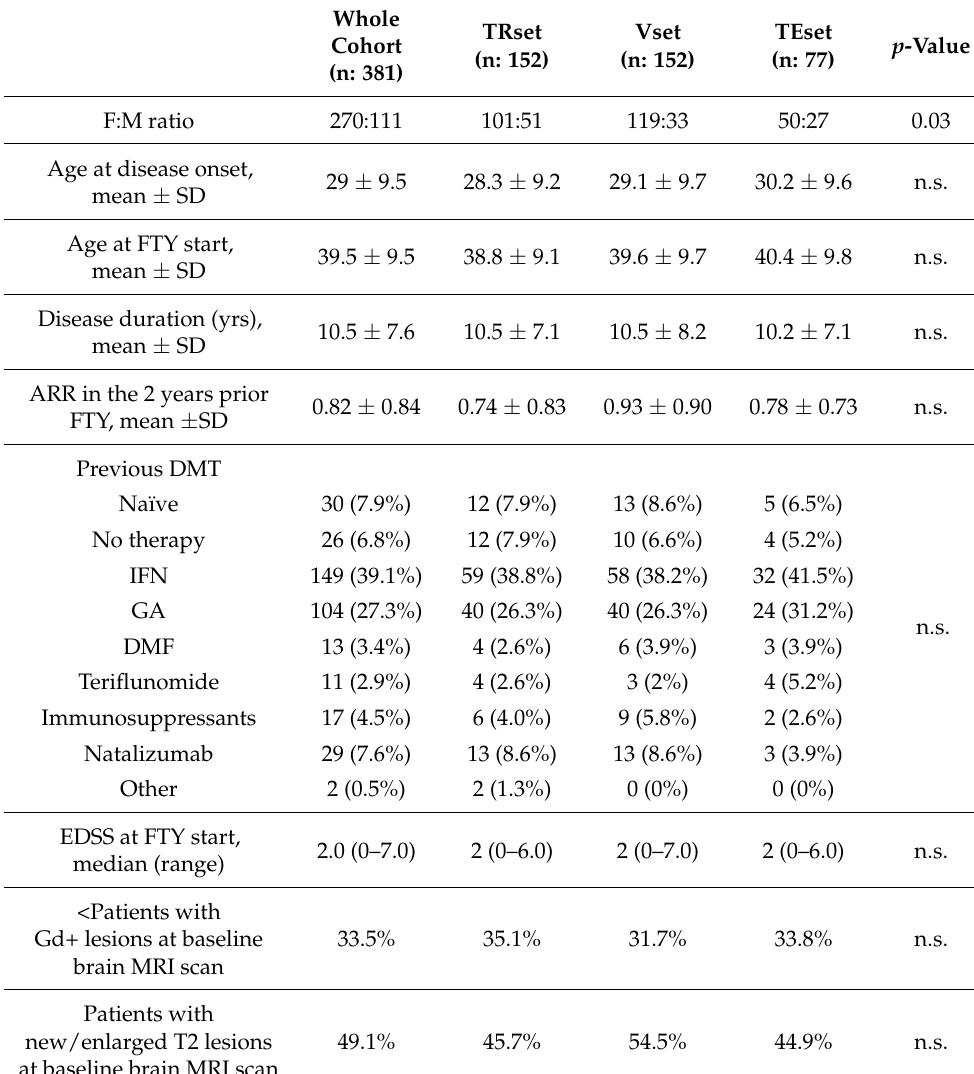
Table 1. Clinical and demographic characteristics of included patients, stratified according to TRset, Vset, and